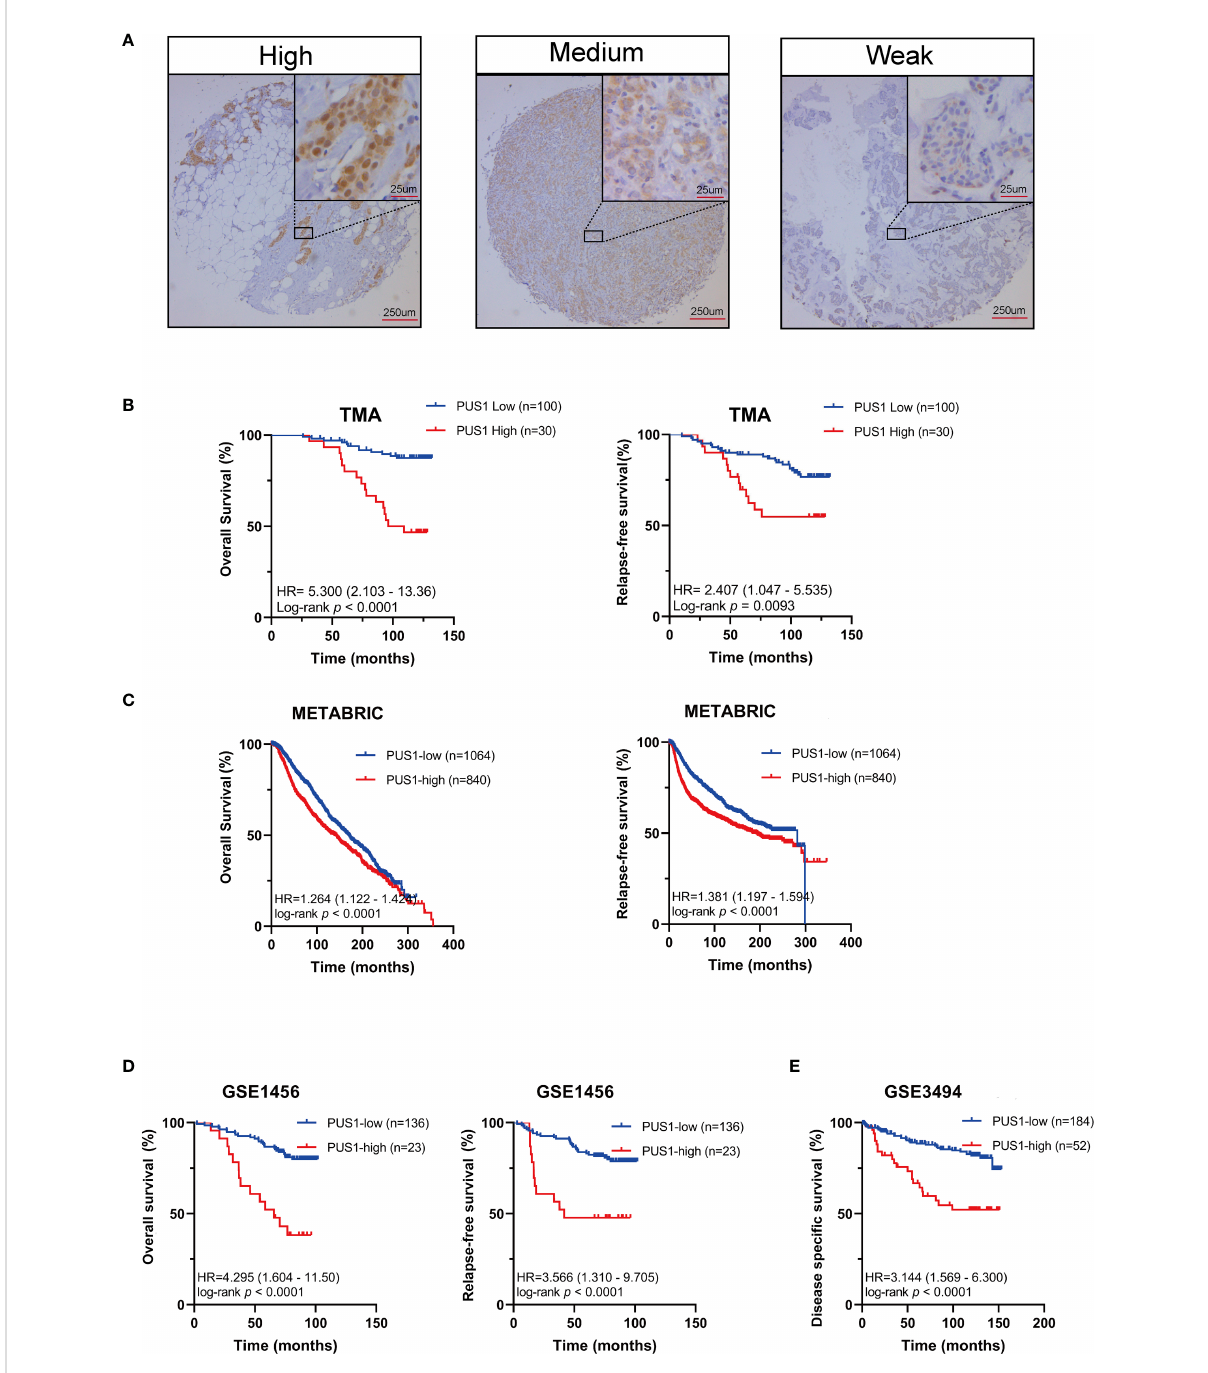
FIGURE 2 UP-regulation of PUS1 correlated with poor prognosis for patients with breast cancer (A) Representative immunohistochemical staining of PUS1 in breast cancer TMA. Brown staining in the nucleus or plasma indicates positive staining. (B) Kaplan – Meier curves analysis of the protein level of PUS1 and the survival of breast cancer patients from the TMA cohort. Red, PUS1 high expression group. Blue, PUS1 low expression group. High PUS1 protein levels were linked to the patients ’ poor overall survival and relapse-free survival. (C, D) The correlation between mRNA expression level of PUS1 and overall survival as well as relapse-free survival in the METABRIC and GSE1456 datasets. At the mRNA level, high PUS1 expression in both cohorts predicted patients ’ adverse outcomes. (E) Kaplan – Meier curves showing the disease-speci fi c survival strati fi ed by PUS1 mRNA expressions in the GSE3494 dataset. TMA, tissue